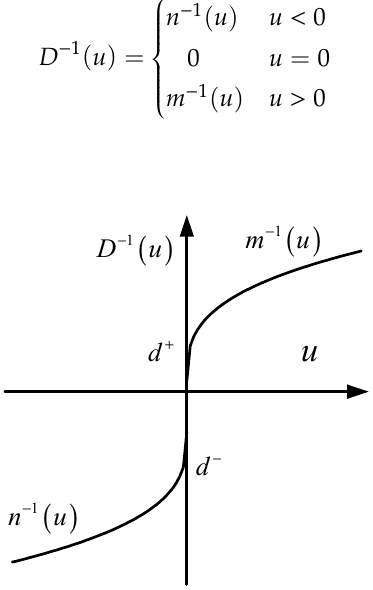
Figure 3. Dead zone inverse.